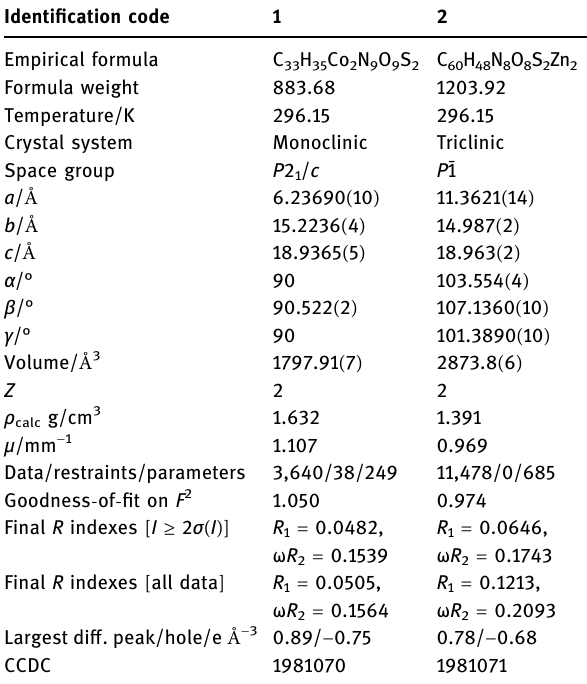
Table 1: Re fi nement details and crystallographic parameters for